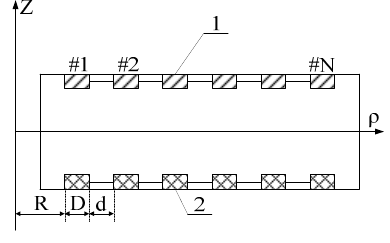
Figure 10. Sensor electrode structure.